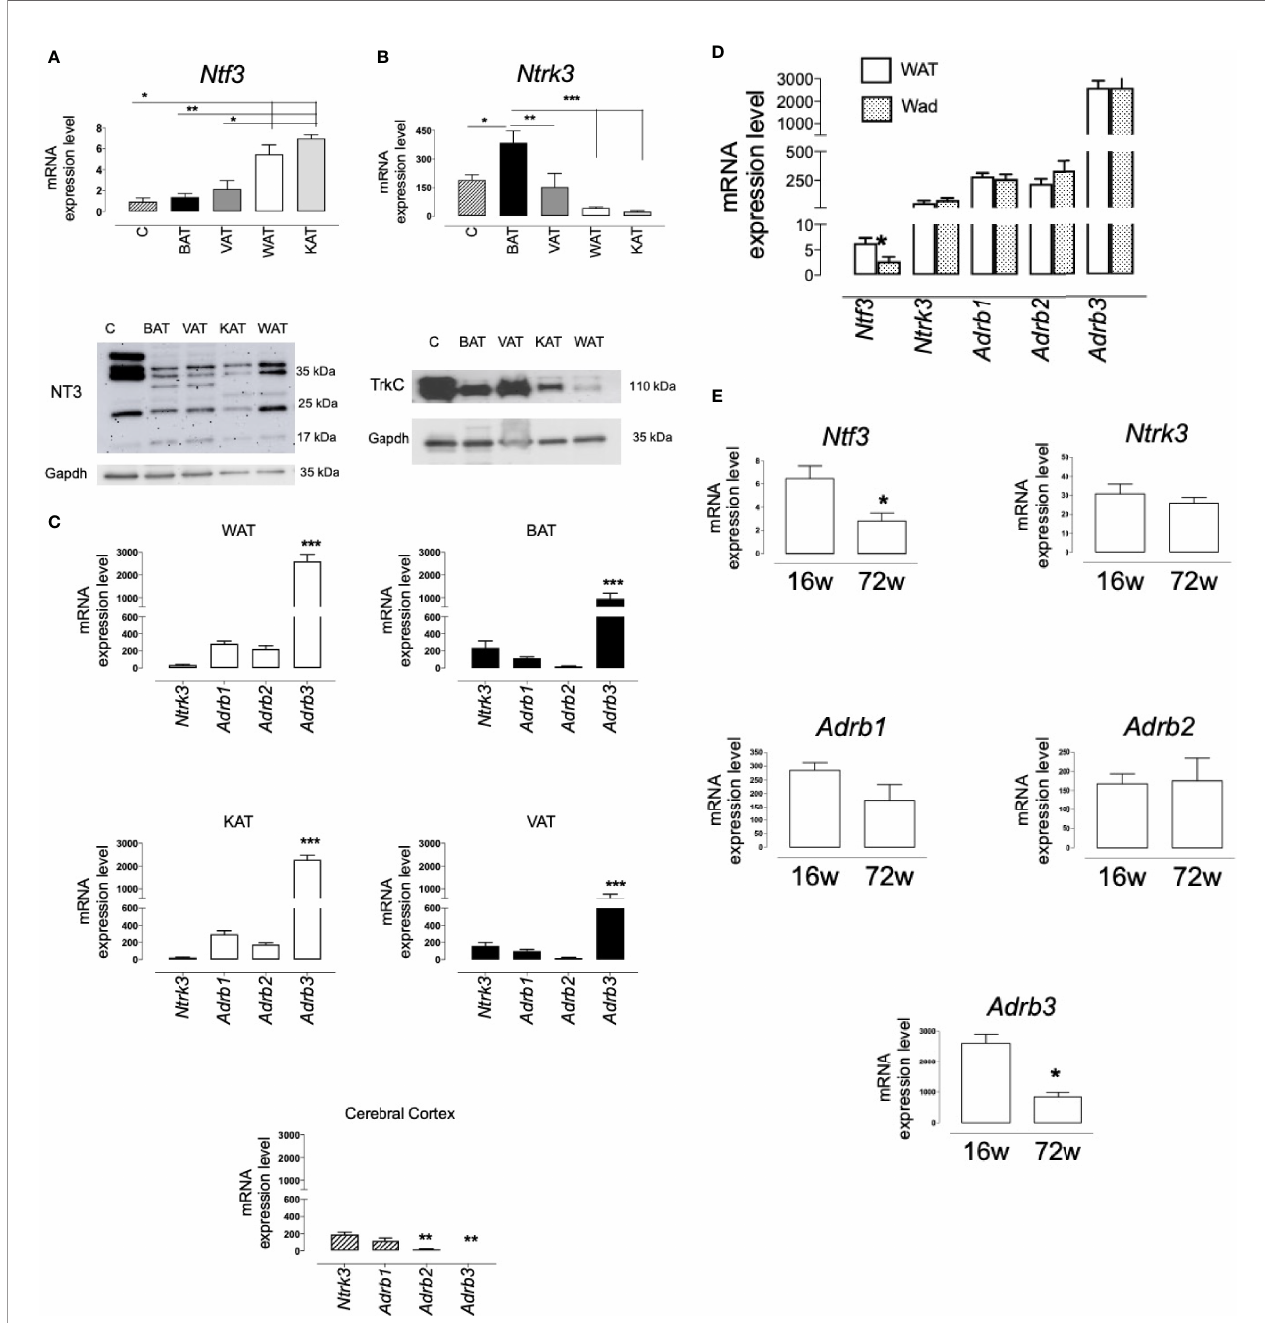
FIGURE 2 | Expression of NT3 and TrkC in rat adipose tissues. mRNA levels and protein expression of NT3 (A) and TrkC (B) in different tissues from Wistar rat: cerebral cortex (C, n = 3), interscapular adipose tissue (BAT, n = 6), perivascular adipose tissue (VAT, n = 5), abdominal adipose tissue (WAT, n = 15) and perirenal adipose tissue (KAT, n = 5), * P < 0.05, ** P < 0.01, *** P < 0.001 vs WAT and KAT ( Ntf3 ) or indicated genes ( Ntrk3 ), one-way ANOVA followed by Newman-Keuls test (C) Comparative representation of the expression of the four membrane receptors assayed ( Ntrk3, Adrb1, Adrb2, and Adrb3) in different tissues (WAT, BAT, KAT, VAT, and cerebral cortex), * P < 0.05 vs the other genes, one-way ANOVA followed by Newman-Keuls test. (D) Expression of Ntf3, Ntrk3, Adrb1, Adrb2, and Adrb3 in WAT and adipocytes isolated from WAT (Wad) (n = 8) * P < 0.05, Student ’ s t test vs WAT. (E) Expression of Ntf3, Ntrk3, Adrb1, Adrb2, and Adrb3 in WAT isolated from young (16 weeks old, n = 14) and aged (72 weeks old, n = 5) Wistar rats, * P < 0.05, Student ’ s t test. Values of mRNA in bar diagrams are expressed as 2 - D Ct x10 4 using Gapdh as a housekeeping gene and represent the mean ±